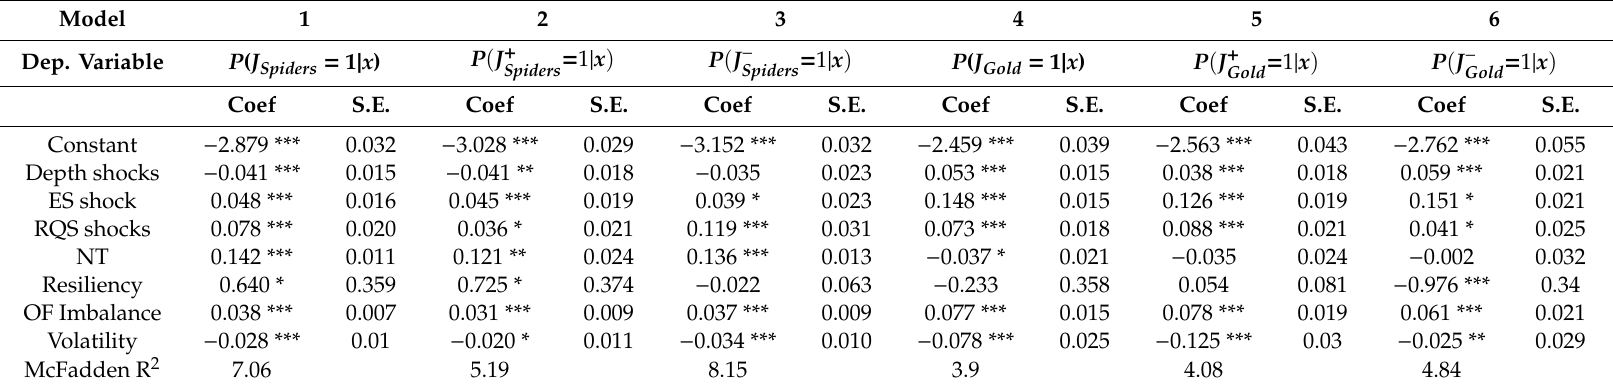
Table 3. Contribution of liquidity and trading activity to the probability of observing